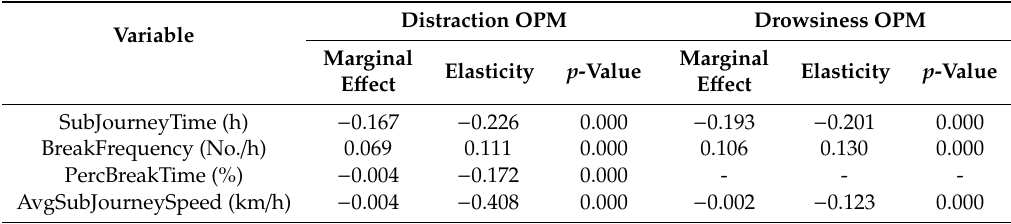
Table 4. Marginal e ff ects and elasticities for Prob( y i =